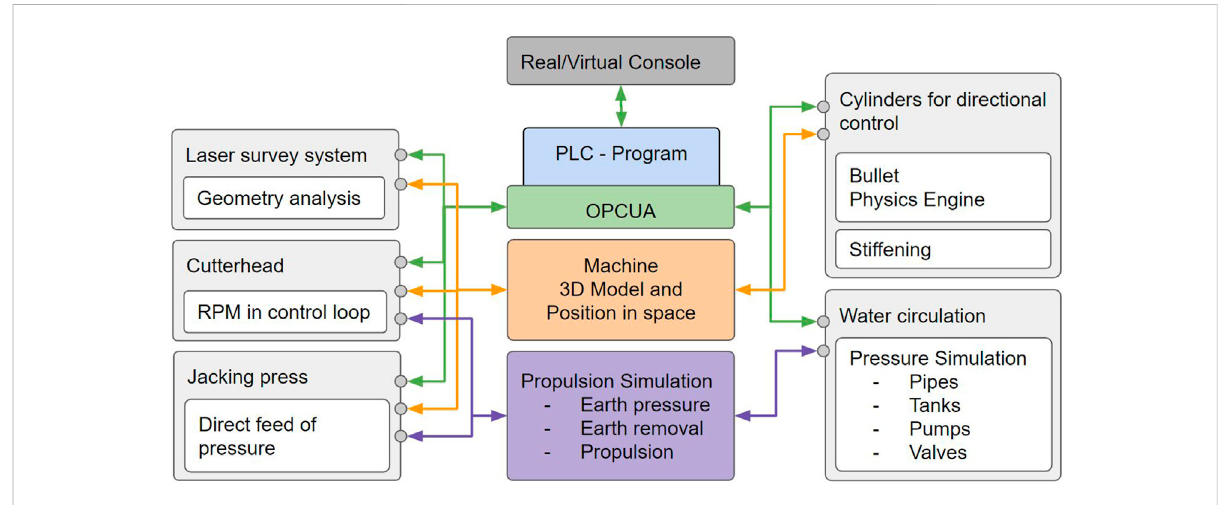
FIGURE 5 Simulation architecture of the virtual tunnel boring